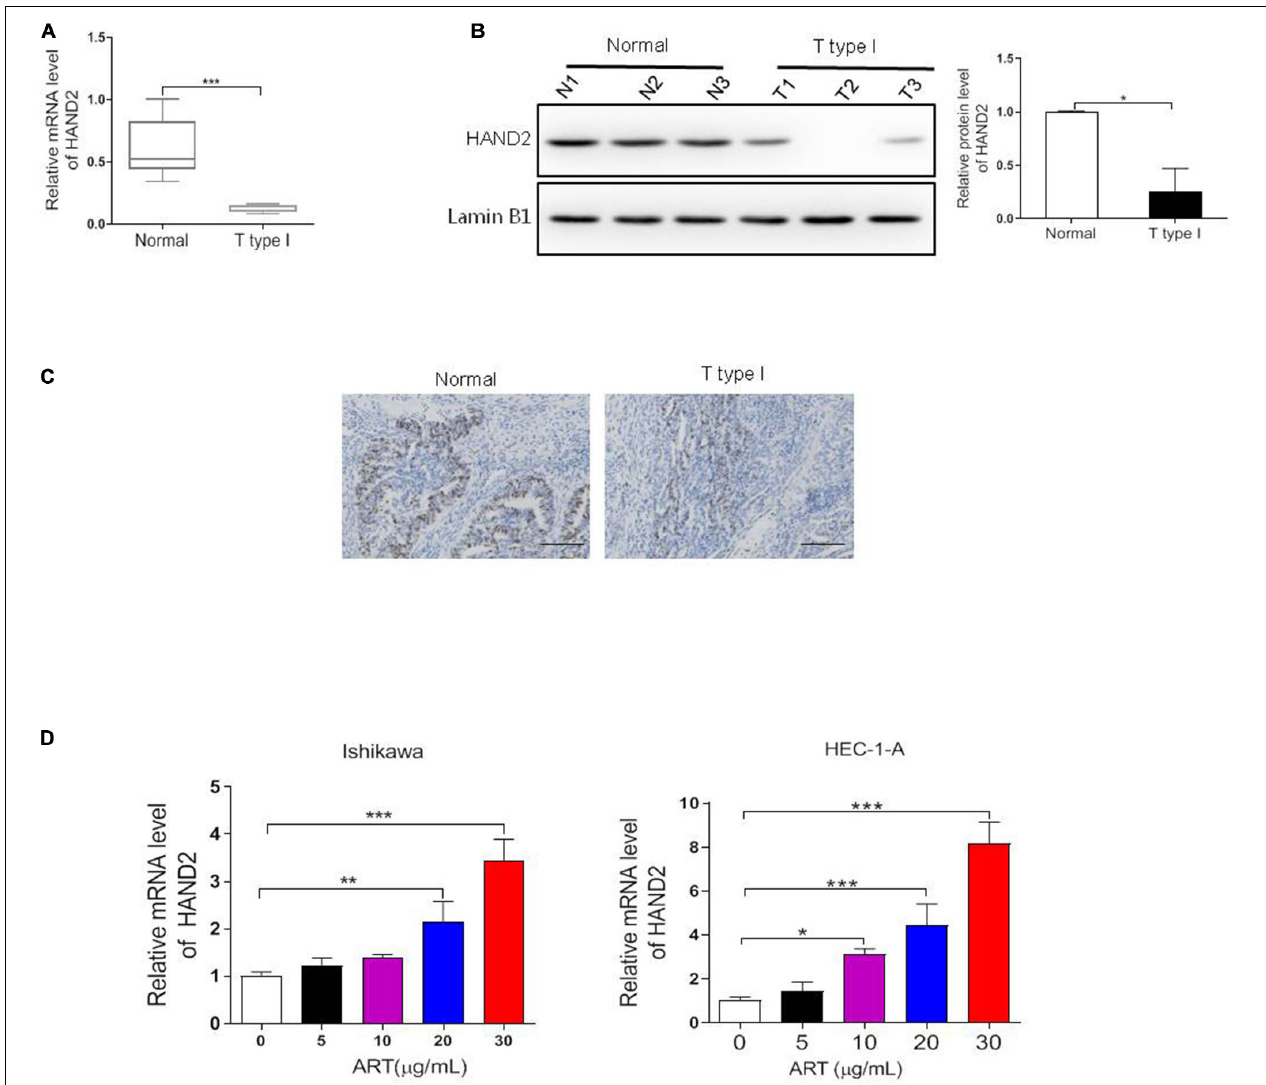
FIGURE 4 | Heart and neural crest derivatives expressed 2 (HAND2) was downregulated in the ER- α -positive EC and regulated by ART treatment. (A–C) The expression level of ER- α in type I EC clinical samples and normal endometrial tissues were assessed by qRT-PCR, western blot and IHC assays. * p < 0.05, *** p < 0.001 vs. the normal group. Bar = 100 µ m. (D) Ishikawa and HEC-1-A cells were treated with ART at different concentrations (0–30 µ g/mL) for 4 days. The mRNA level of HAND2 was assessed by qRT-PCR analysis. The data were showed as the mean ± SD, * p < 0.05, ** p < 0.01, *** p < 0.001 vs. the 0 µ g/mL of ART-treated